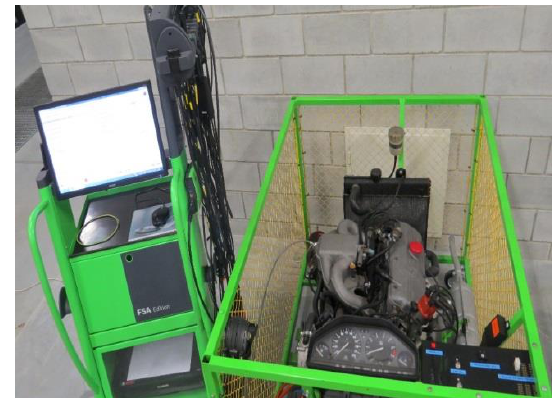
Fig. 7. Test stand of the BMW M10B18